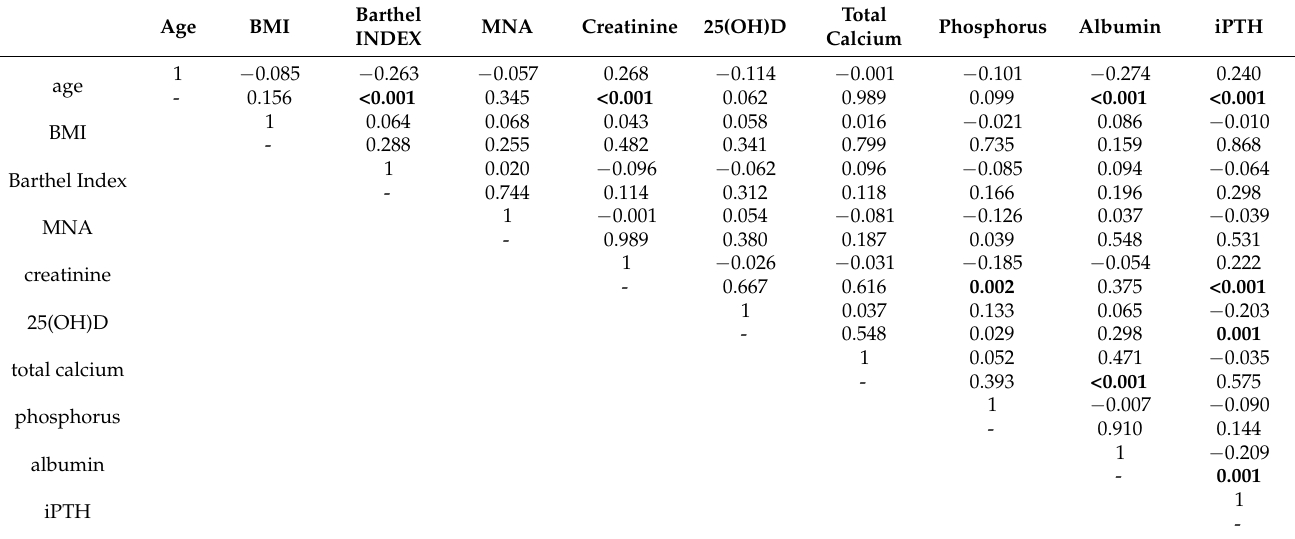
Table 2. Pearson correlation coefficients of analyzed